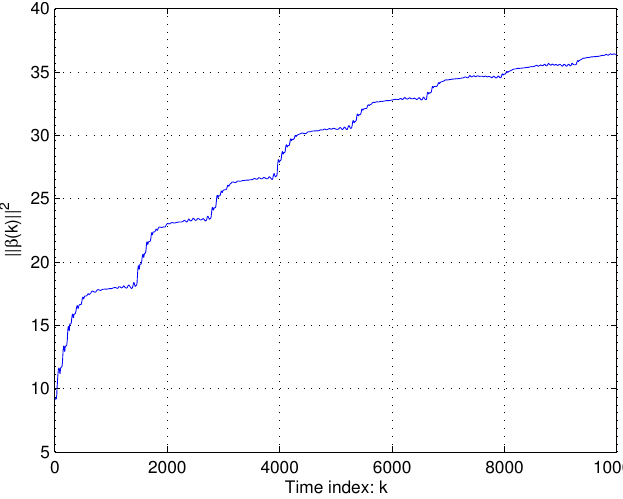
Figure 12. Weight parameters of the MiFREN